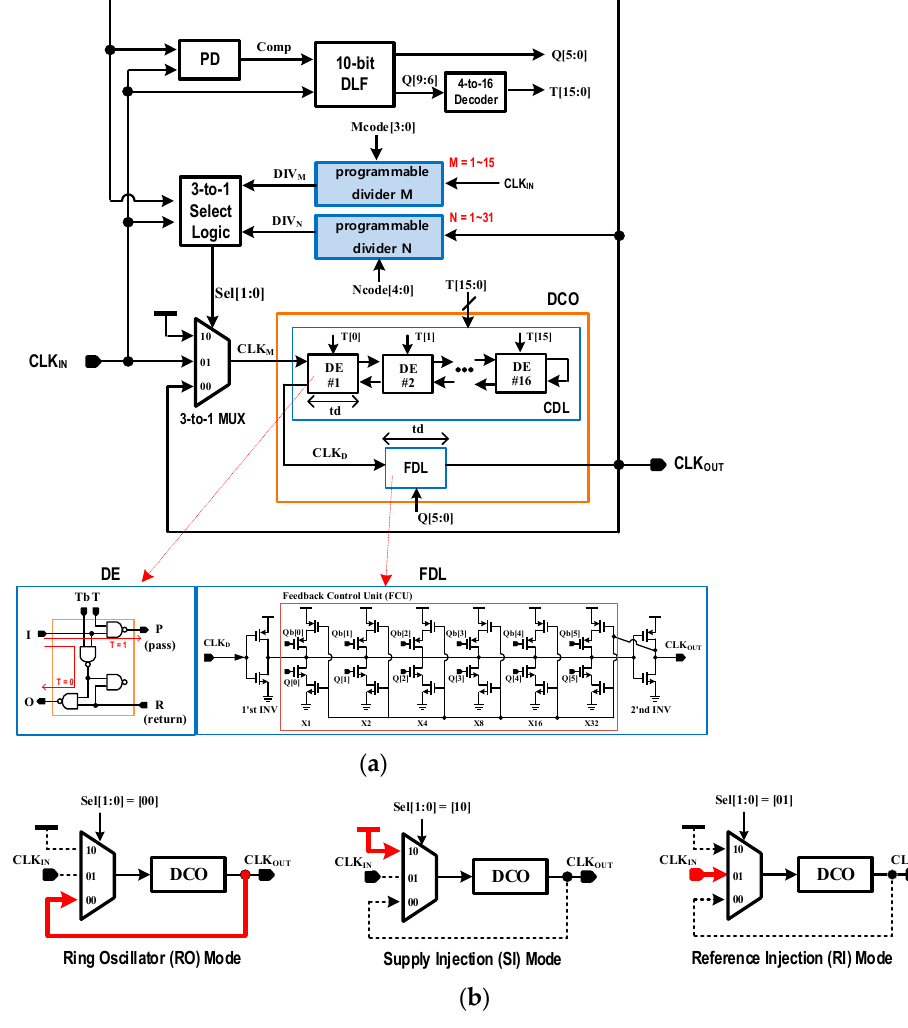
Figure 4. ( a ) Proposed N/M ‐ ratio digital MDLL clock generator architecture with a new programmable divider (N & M). ( b ) Three operation modes: RO, SI, and RI.